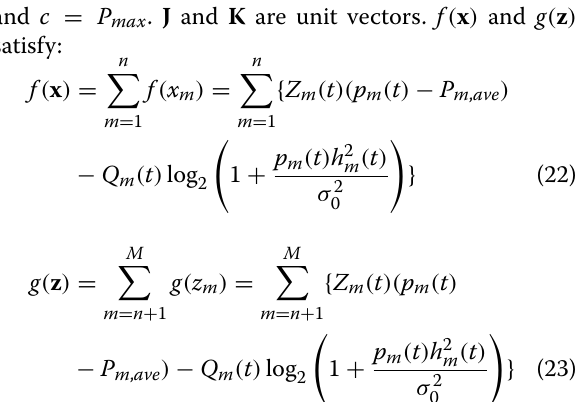
Algorithm 1 ADMM-based power allocation